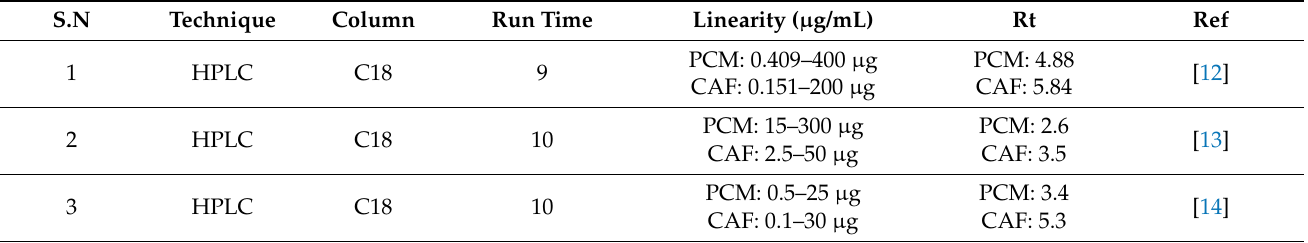
Table 7. Comparison of some chromatographic characteristics of the current UPLC procedure with previously published methods for concurrent quantification of PCM and